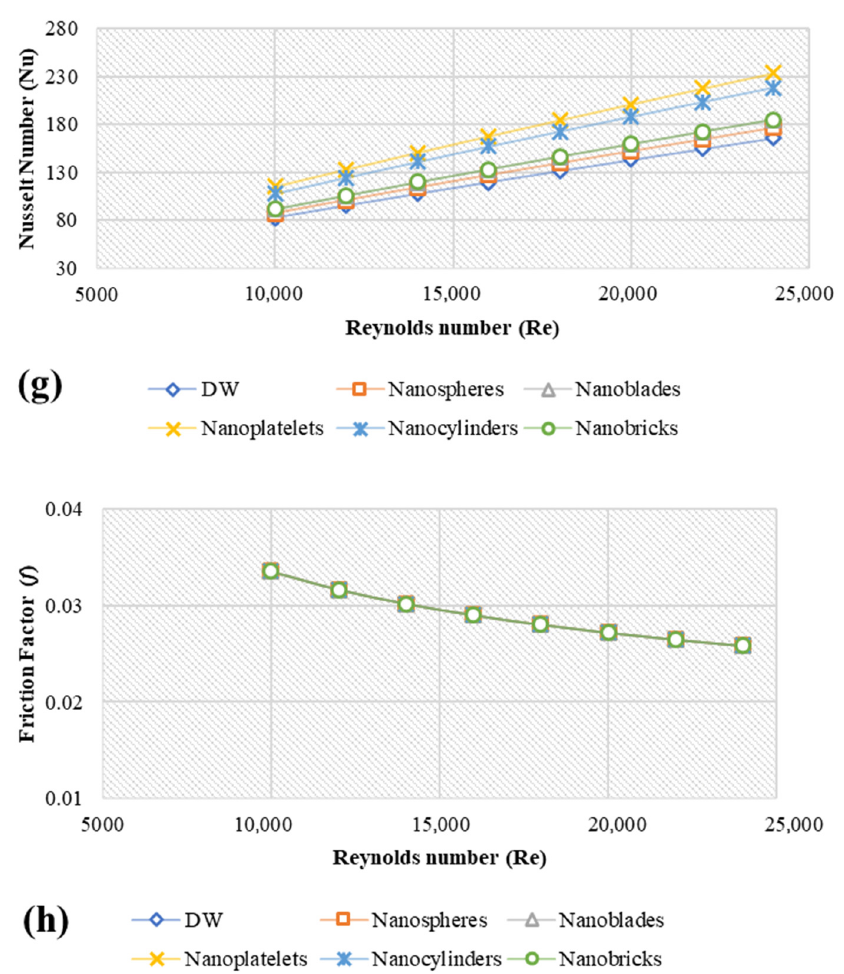
Figure 6. Simulation data of average Nusselt numbers and friction factors for different metal oxides and different nanoparticles shape at 4 vol.%, 20 nm, and 293 K; ( a ) Nu-Al 2 O 3 , ( b ) f -Al 2 O 3 , ( c ) Nu-CuO, ( d ) f -CuO, ( e ) Nu-SiO 2 , ( f ) f -SiO 2 , ( g ) Nu-ZnO, ( h ) f